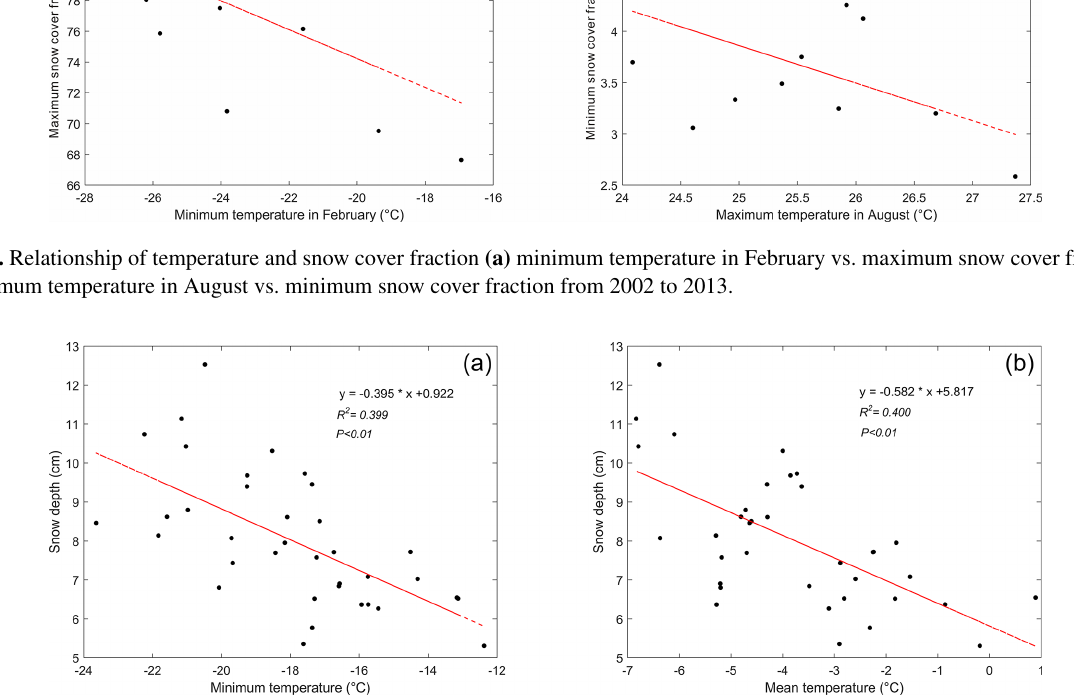
Figure 9. Relationship of snow depth and (a) T min in March and (b) T mean in March from 1979 to